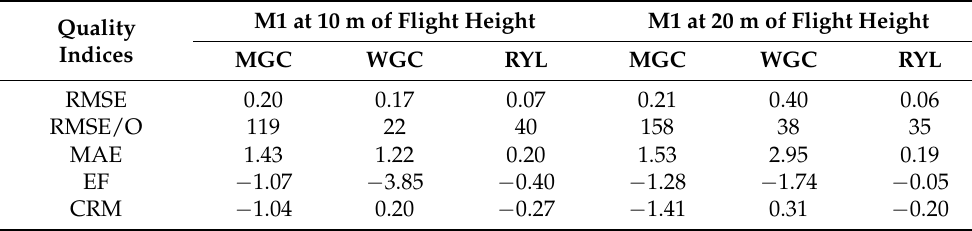
Table 5. Modelling quality indices (RMSE, RMSE/ ¯O, MAE, EF and CRM for more details see Table 1) used to evaluate the goodness of fit for method 1 (M1) at 10 and 20 m of flight height in estimating the maize green cover (MGC), the weed green cover (WGC) and relative yield loss (RYL). M1 at 10 m of Flight Height M1 at 20 m of Flight Height Quality Indices MGC